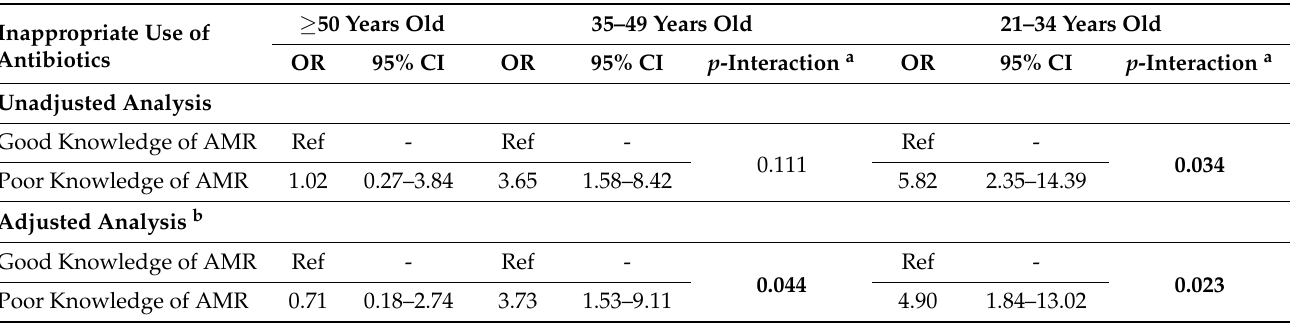
Table 5. Association between inappropriate use of antibiotics and poor knowledge of AMR, according to age group.